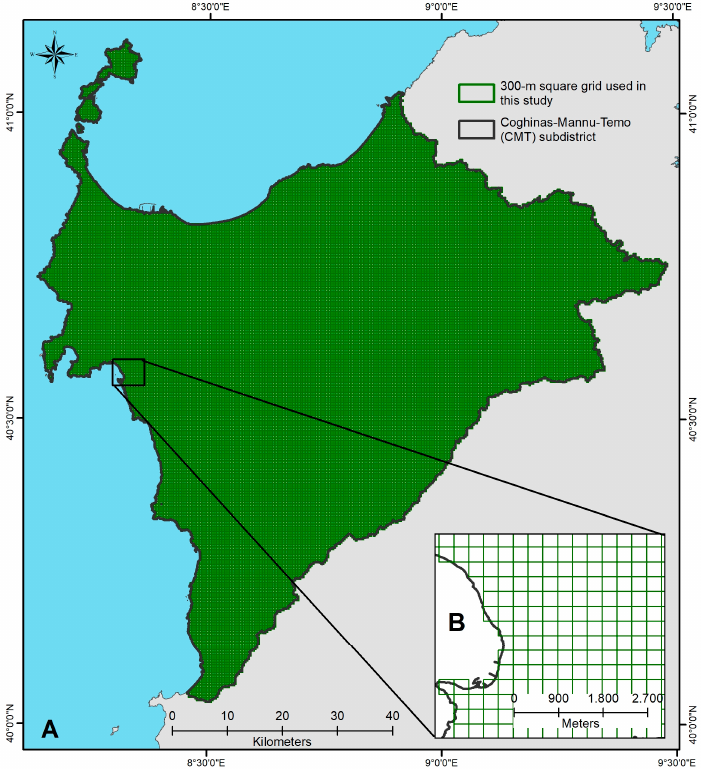
Figure 3. The 300 m vector square grid used in this study: extent of the grid with reference to the Coghinas-Mannu-Temo subdistrict (panel A , no. of cells: 62,231), and detail (panel B ).